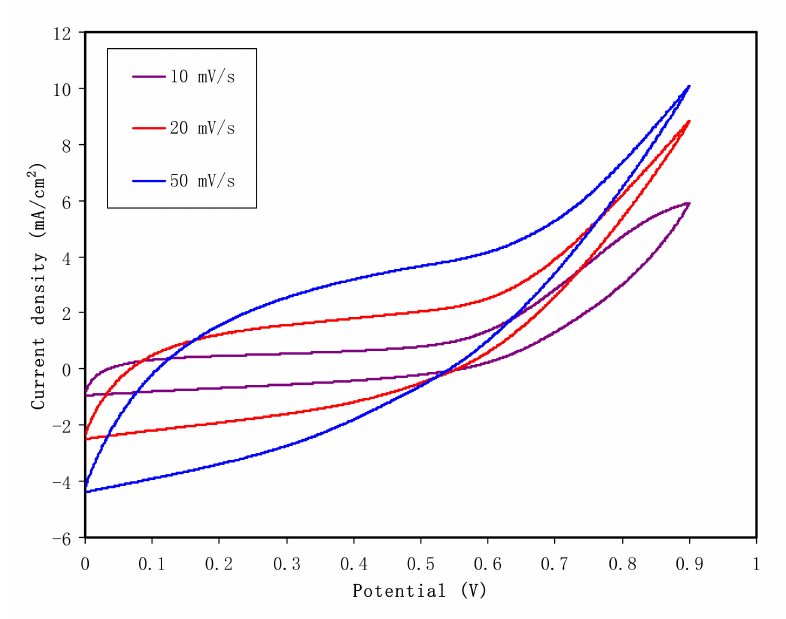
Figure 10. Cyclic voltammetry of EDLC fabrication for the CSAG4 sample in the potential range 0 to 0.9 V at the scan rates 10, 20, and 50 mV s − 1 at room temperature.